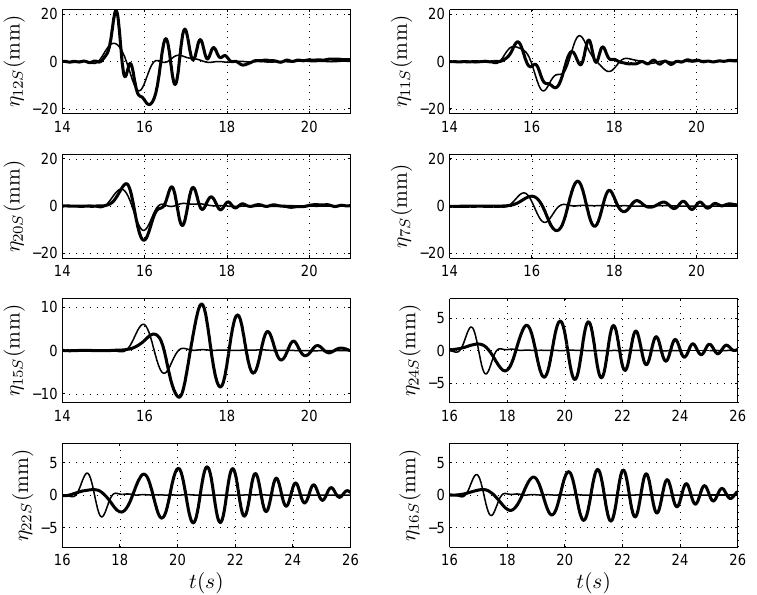
Fig. 8. Free water surface elevation as measured in the laboratory experiments (thick line) and as computed with the same numerical model but in the shallow water approximation (thin line).